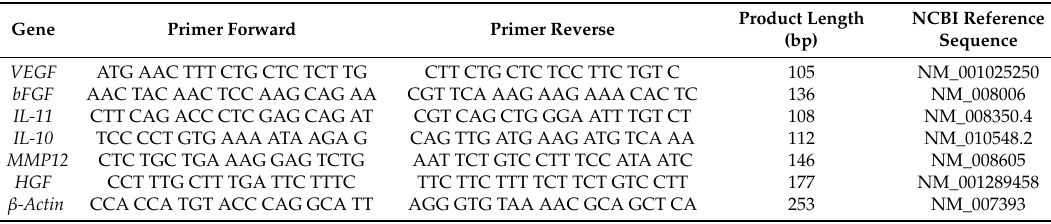
Table 1. Primer used for qPCR